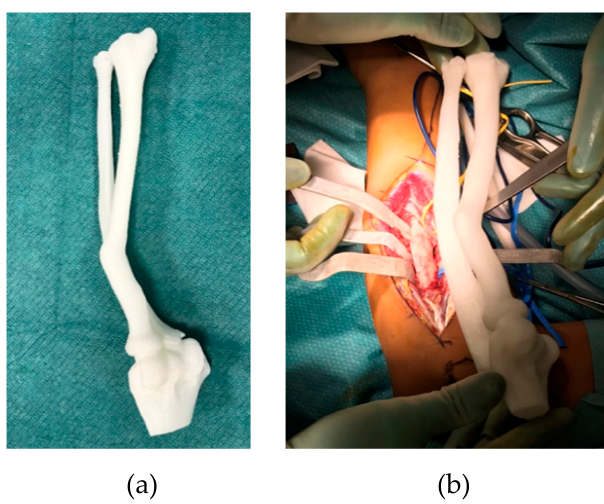
Figure 10. ( a ) 3D printed model in sterilizable high-temperature poly-lactic acid (HTPLA). ( b ) Intraoperative assessment of the bony deformity, by the use of the 3D-printed model. In this case, an accurate